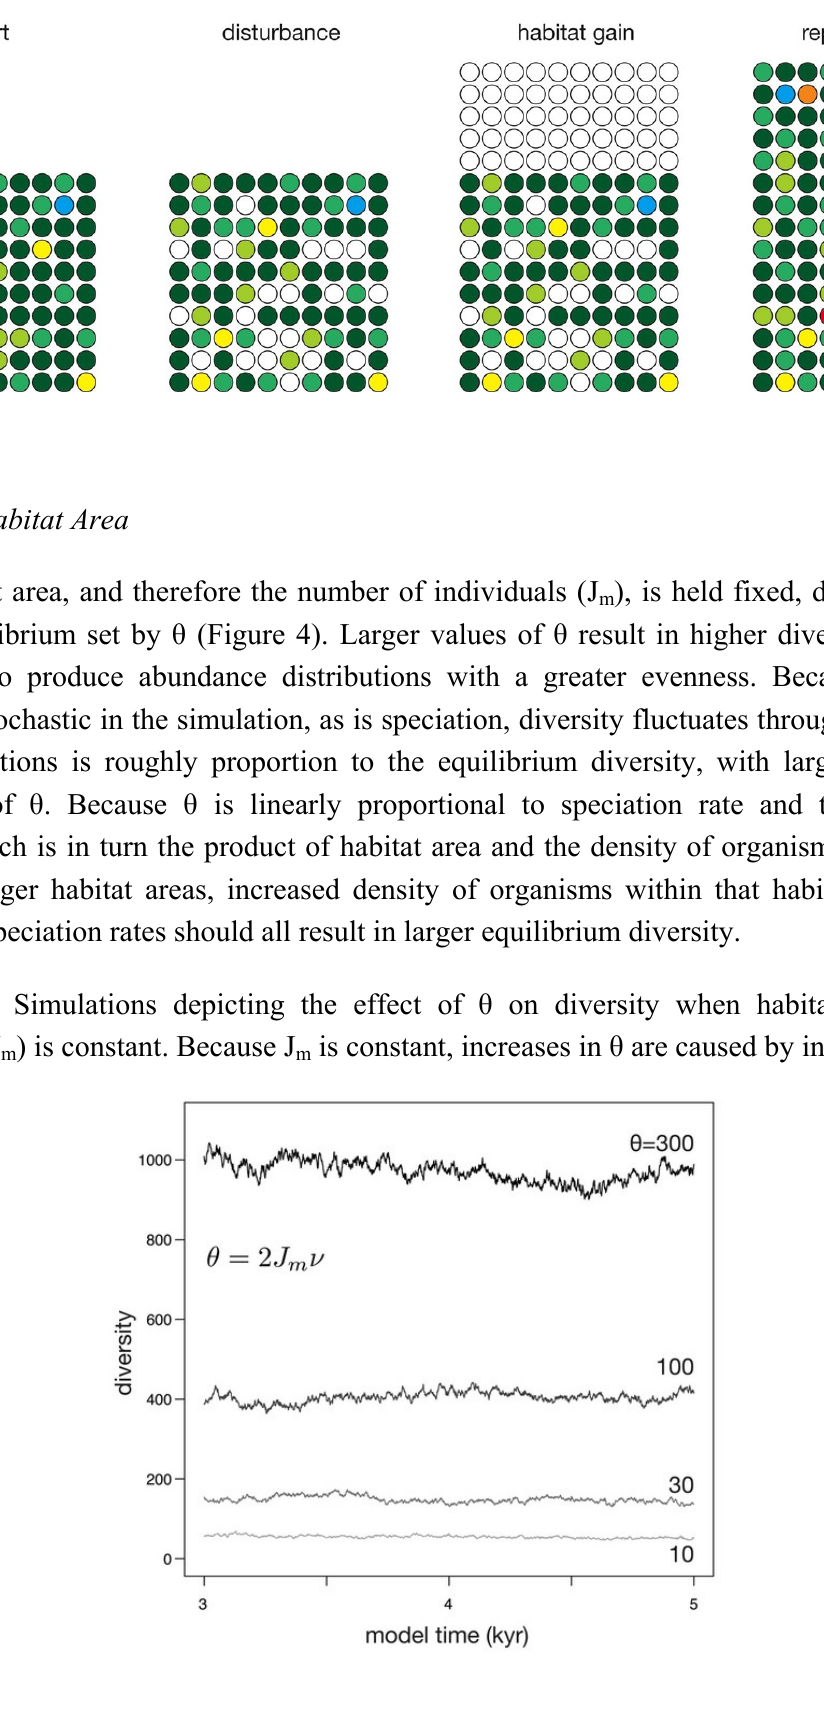
Figure 3. Simulation of habitat gain, in which a specified number of sites are added following disturbance and preceding replacement. Two new species (red and orange) were produced in this example.